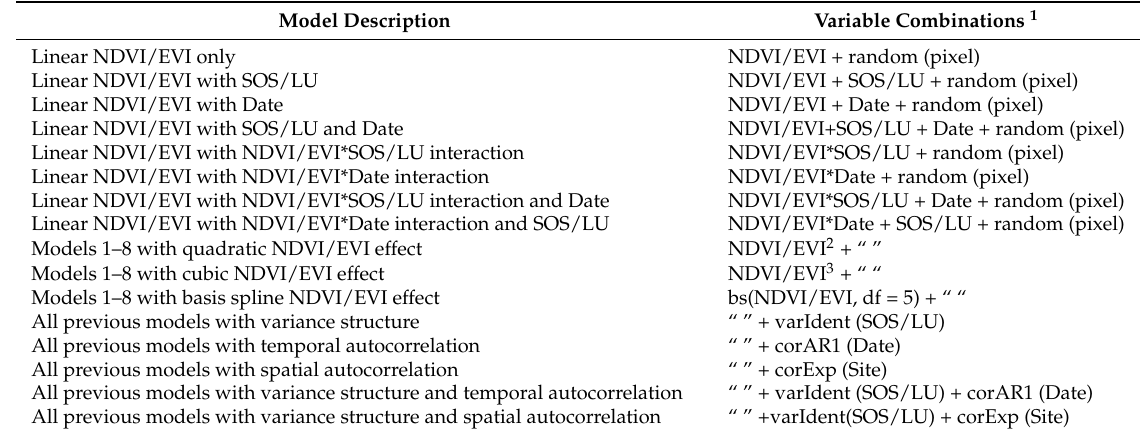
Table A1. Mixed effect models compared to select the top models of biomass, chlorophyll, crude protein and IVDMD. Model selection was done separately for all SOS classes (in public grassland land use) and for all land use classes (in early SOS